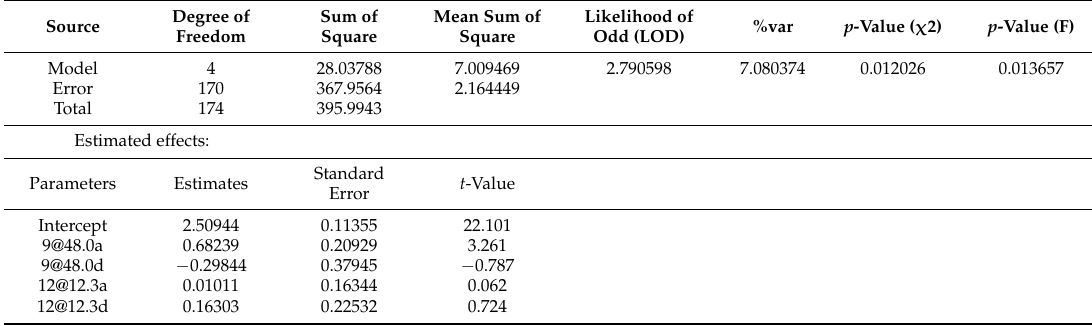
Table 4. Evaluation of epistatic effect of quantitative trait loci (QTL) associated with late blight resistance from chromosome 9 and 12 in tomato. Table presents the direct outputs including